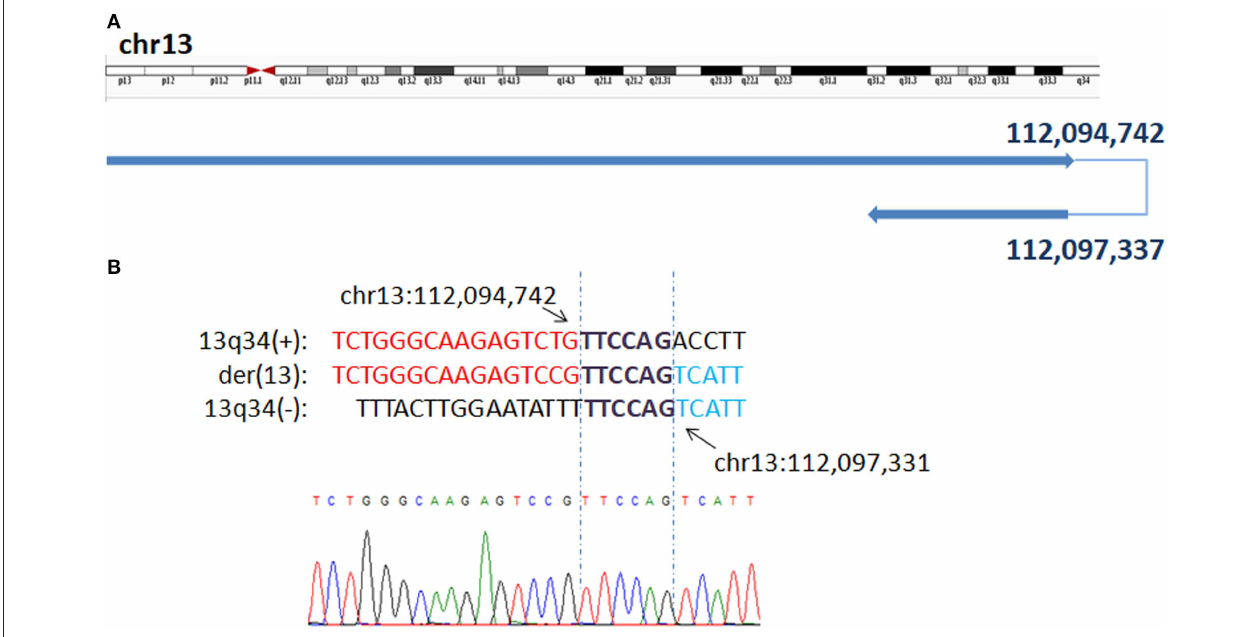
FIGURE 1 | Breakpoints in P1 (A) Breakpoints analysis found two breakpoints were at chr13q34:112,094,742 and chr13q34: 112,097,337, which demonstrate inv dup 13q31.2q34 and 13q34qter deletion on der 13 sequences. (B) The breakpoints mapped at the base-pair level by Sanger sequencing. Sequences in bold purple represent microhomology. Rearrangement junction sequences (middle line) and matching reference sequences (top and bottom lines) are shown with different colors depending on the involved chromosome region.